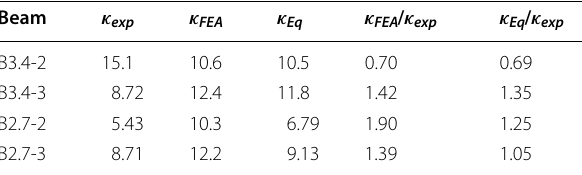
Table 3 Comparisons of the different effective stiffness obtained from various